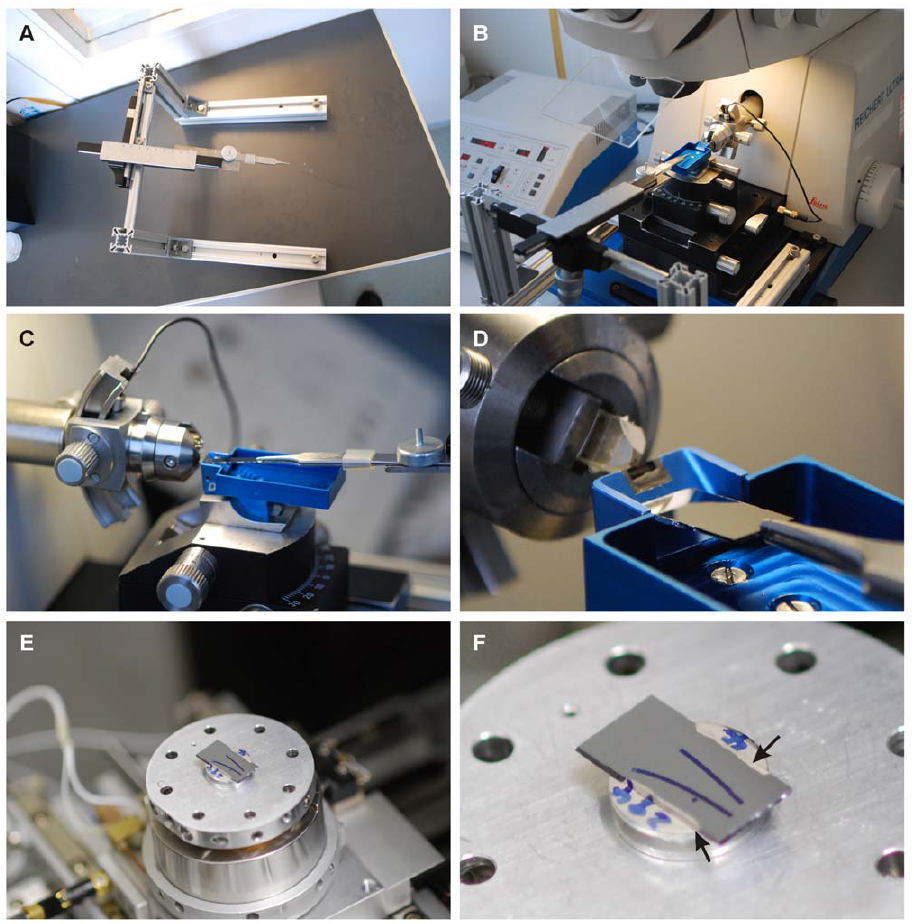
Figure 1. A custom-built positioning device to mount ribbons of serial sections onto a hydrophylized silicon wafer. A: Frame carrying an angled micromanipulator and forceps for wafer positioning. B: Wafer positioning frame mounted onto the ultramicrotome. C: Positioning of the wafer in the diamond knife boat (blue part). Note the extended size of the knife boat. D: Close-up showing the position of the wafer close to the edge of the diamond knife. A tissue block mounted on the microtome arm is visible on the left. E: A silicon wafer strip glued to the SEM sample holder within the sample chamber of the SEM. F: Close-up showing the wafer mounted on sample holder. The wafer contains two ribbons (black stripes). A jumper link was used to establish a conductive connection between the wafer and the sample holder